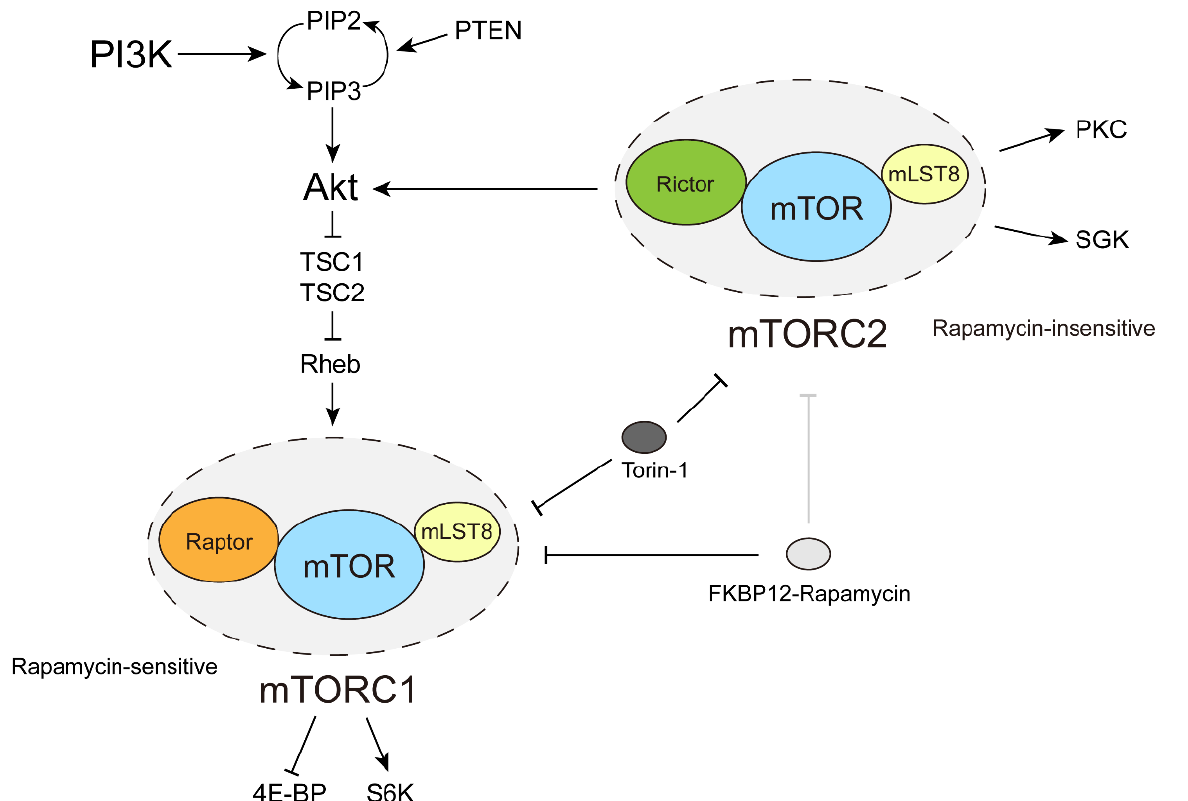
Figure 1. mTOR pathway. The major signaling pathways of mTORC1 and mTORC2. Arrows indicate facilitation and activation, and blocks indicate inhibition.